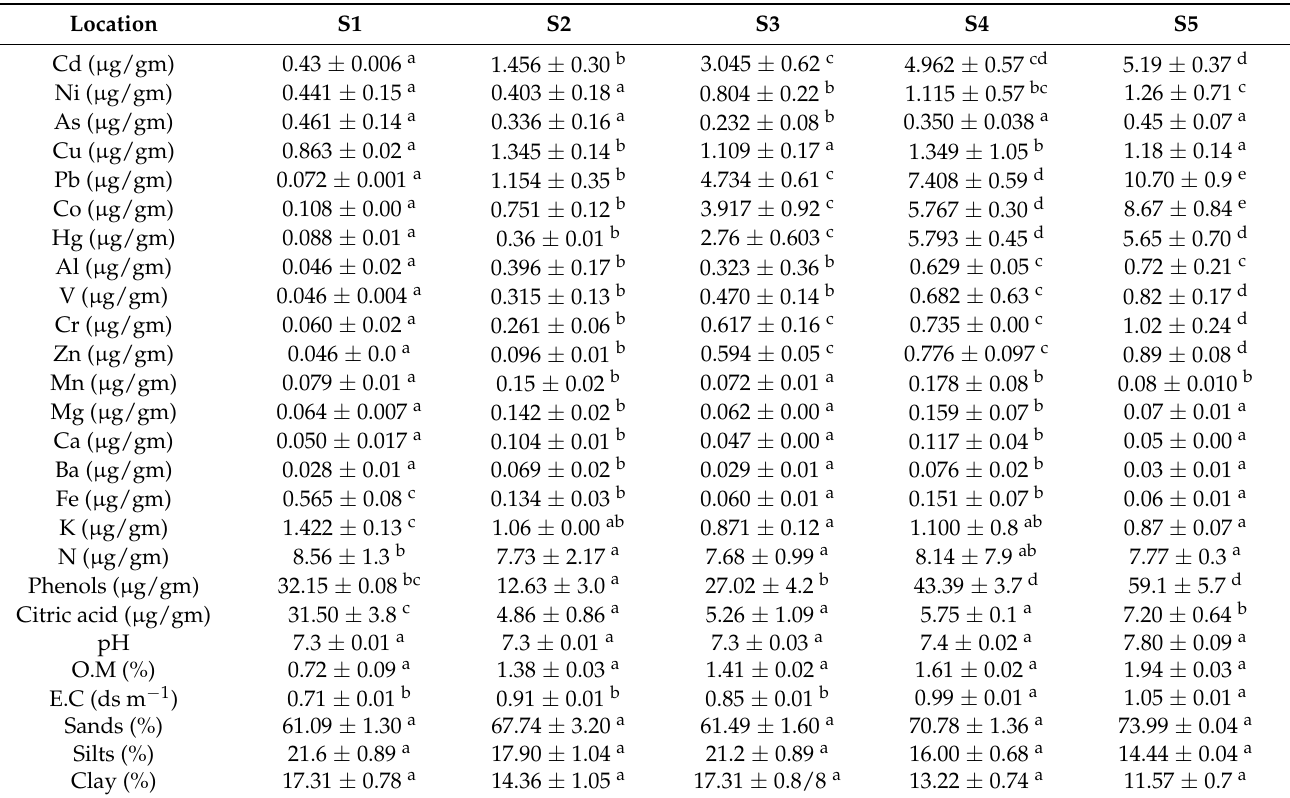
Table 2. Concentration of heavy metals ( µ g/gm), minerals, phenols, acetic acid, pH, organic matter, electric conductivity and texture in the studied site’s soils. Different letters (a–d) represent the significant differences between the effect of heavy metal stress in the different target sites (Tukey test ( p <